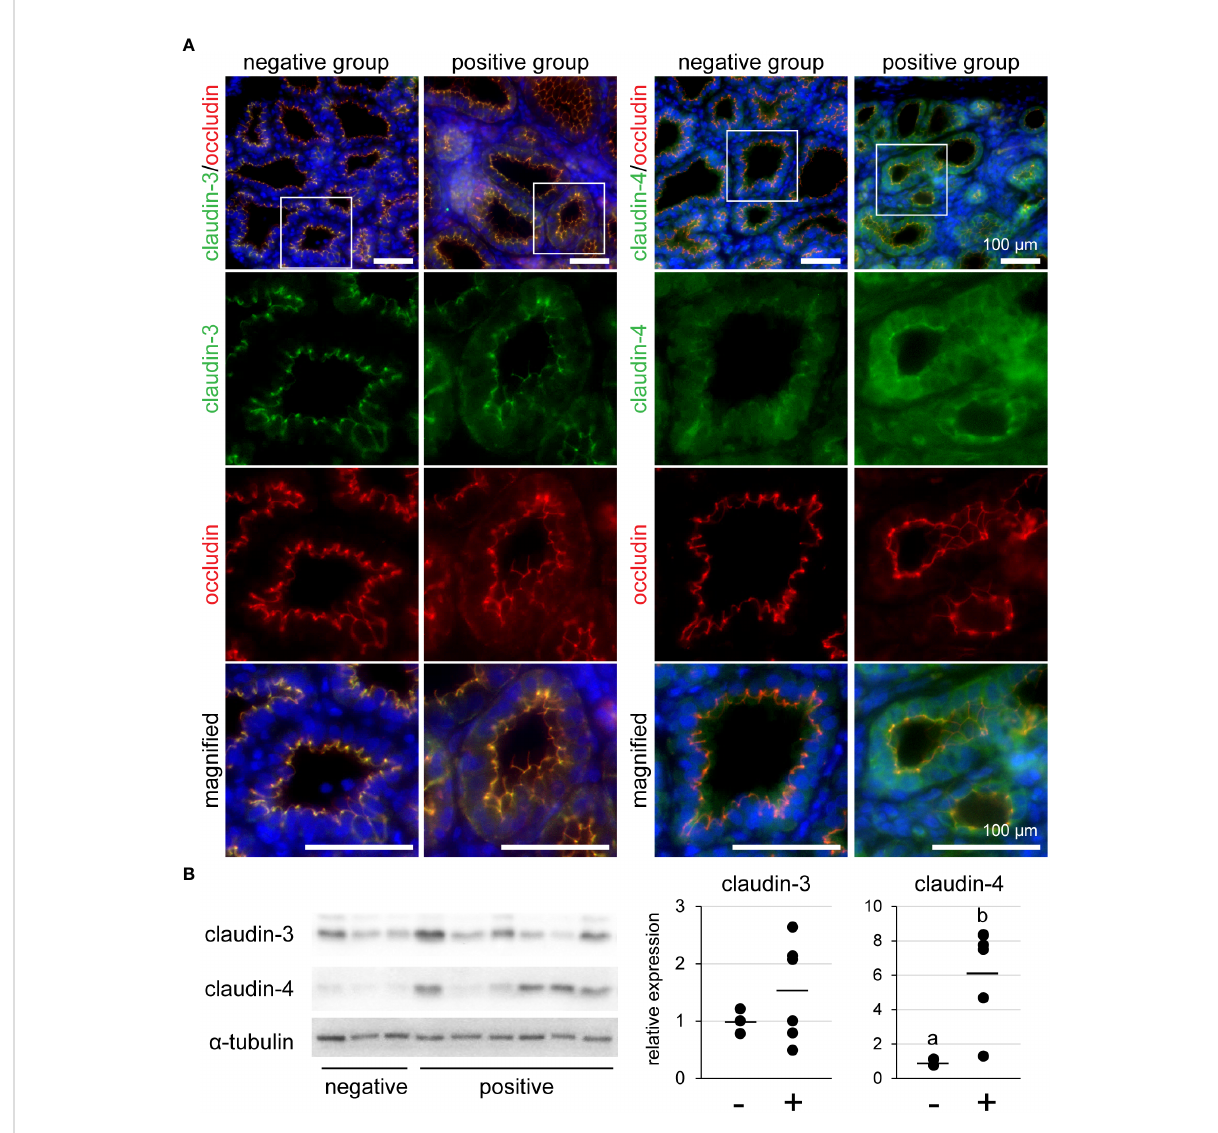
FIGURE 5 (A) Representative images of immuno fl uorescence against claudin-3 and claudin-4 in tertiary lymphoid organ-positive and -negative goat mammary gland tissues. Occludin is a marker for tight junctions. Scale bar, 100 m m. (B) Bands detected by western blot and the results of densitometry analyses. Alpha-tubulin serves as internal control; ( − ) lymphocyte aggregation-negative group; (+) lymphocyte aggregation- positive group. Different letters indicate a signi fi cant difference between groups (p <